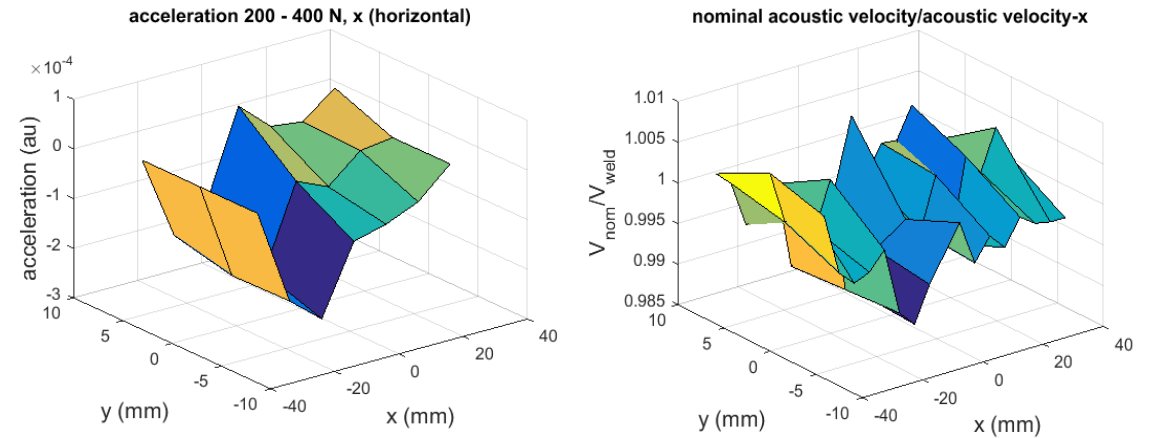
Figure 10. Acceleration from electronic speckle-pattern interferometry (ESPI) measurement and acoustic velocity relative to nominal